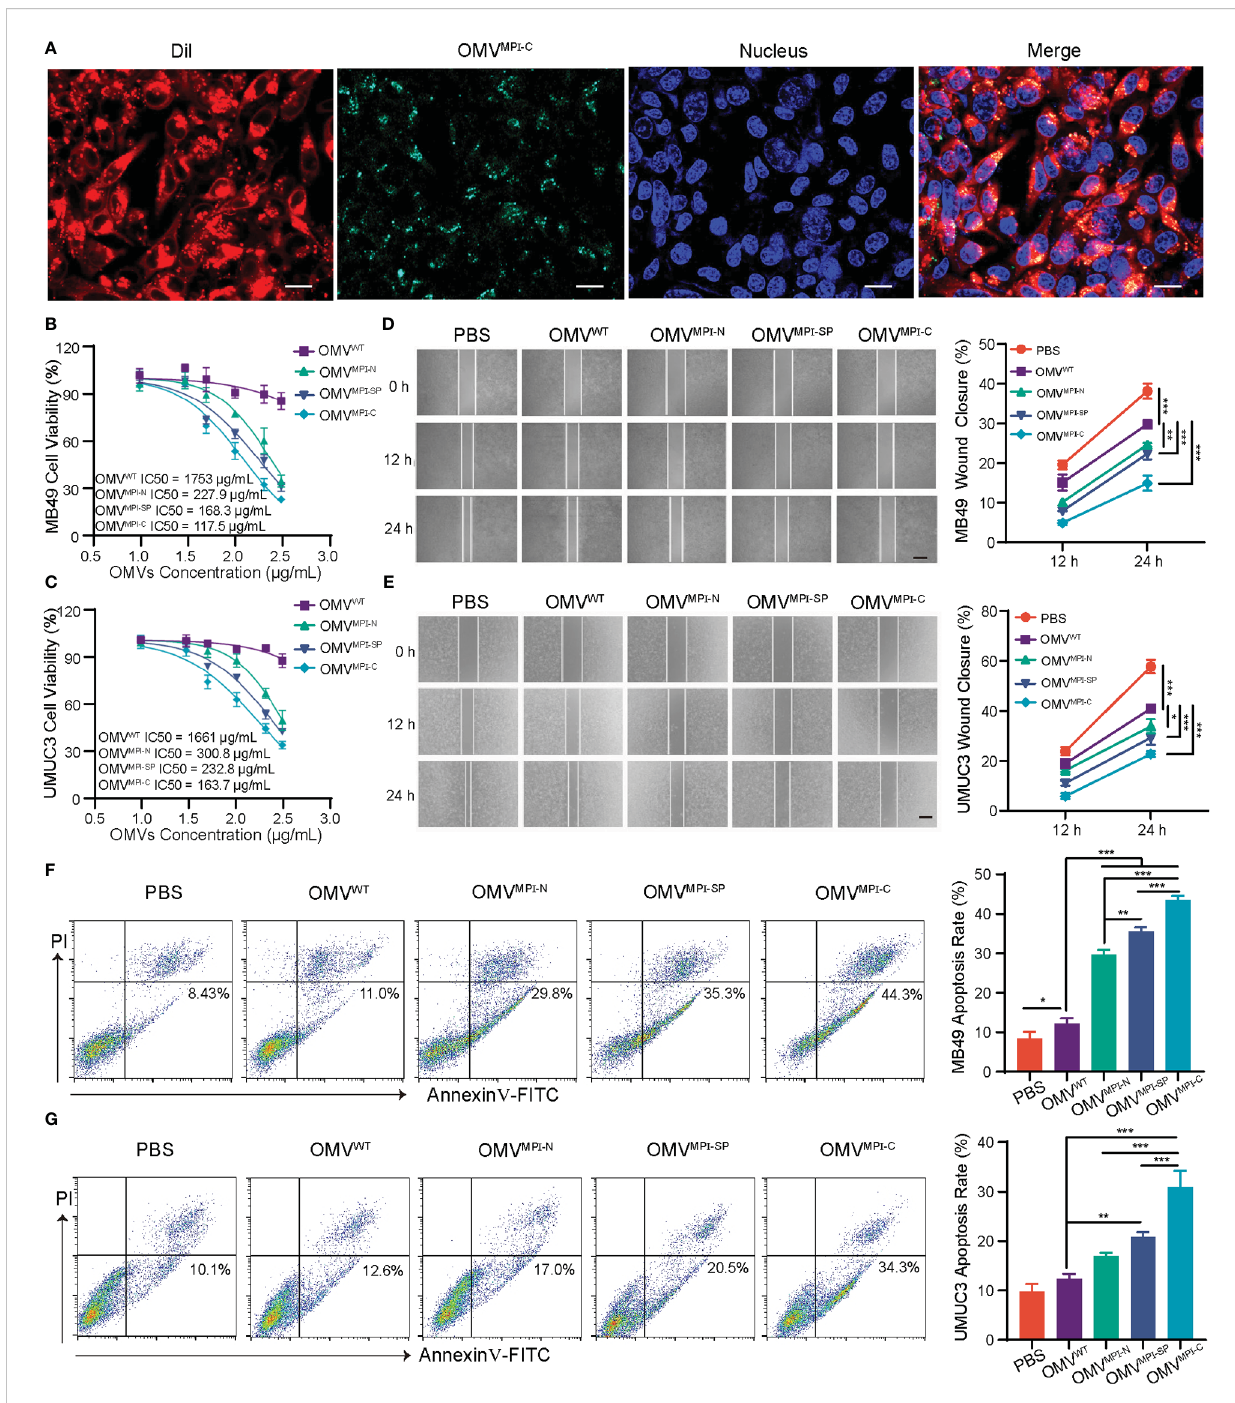
FIGURE 2 The antitumor effects of bioengineered OMVs in vitro . (A) CLSM images representing DiL-labeled OMV MPI-C endocytosis by MB49 cells after 6-h incubation. Cell nuclei were stained with Hoechst 33342 (blue). Scale bar = 20 m m. IC 50 curves of MB49 (B) and UMUC3 (C) after treatment with different OMV formulations for 24 h ( n = 3). Representative images and quanti fi cation analysis of MB49 (D) and UMUC3 (E) cell wound-healing assay after treatment with different OMV formulations (100 m g/ml). Images were obtained at 0, 12, and 24 h ( n = 3). Scale bars = 100 m m. Representative FCM results and corresponding quanti fi cation analysis showing the percentages of apoptotic MB49 (F) and UMUC3 (G) cells after treatment with different OMV formulations (100 m g/ml) for 48 h ( n = 3). Data in (B – G) are presented as mean ± SD. ns, no signi fi cance; * p < 0.05, ** p < 0.01, *** p <